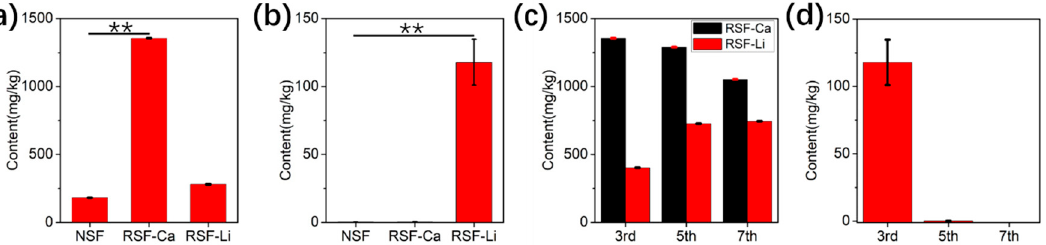
Figure 3. The elemental content in the RSF. ( a ) The content of Ca. ( b ) The content of Li. ( c ) The Ca content in the two RSF samples on days 3, 5 and 7 of dialysis. ( d ) The Li content in the RSF-Li on days 3, 5 and 7 of dialysis. Prolonging the dialysis time can completely remove Li, but not Ca. (** p < 0.01, n = 3).